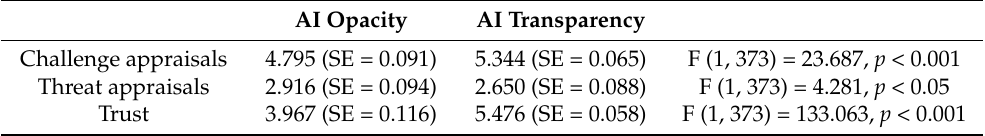
Table 4. Results of the one-way ANOVA.